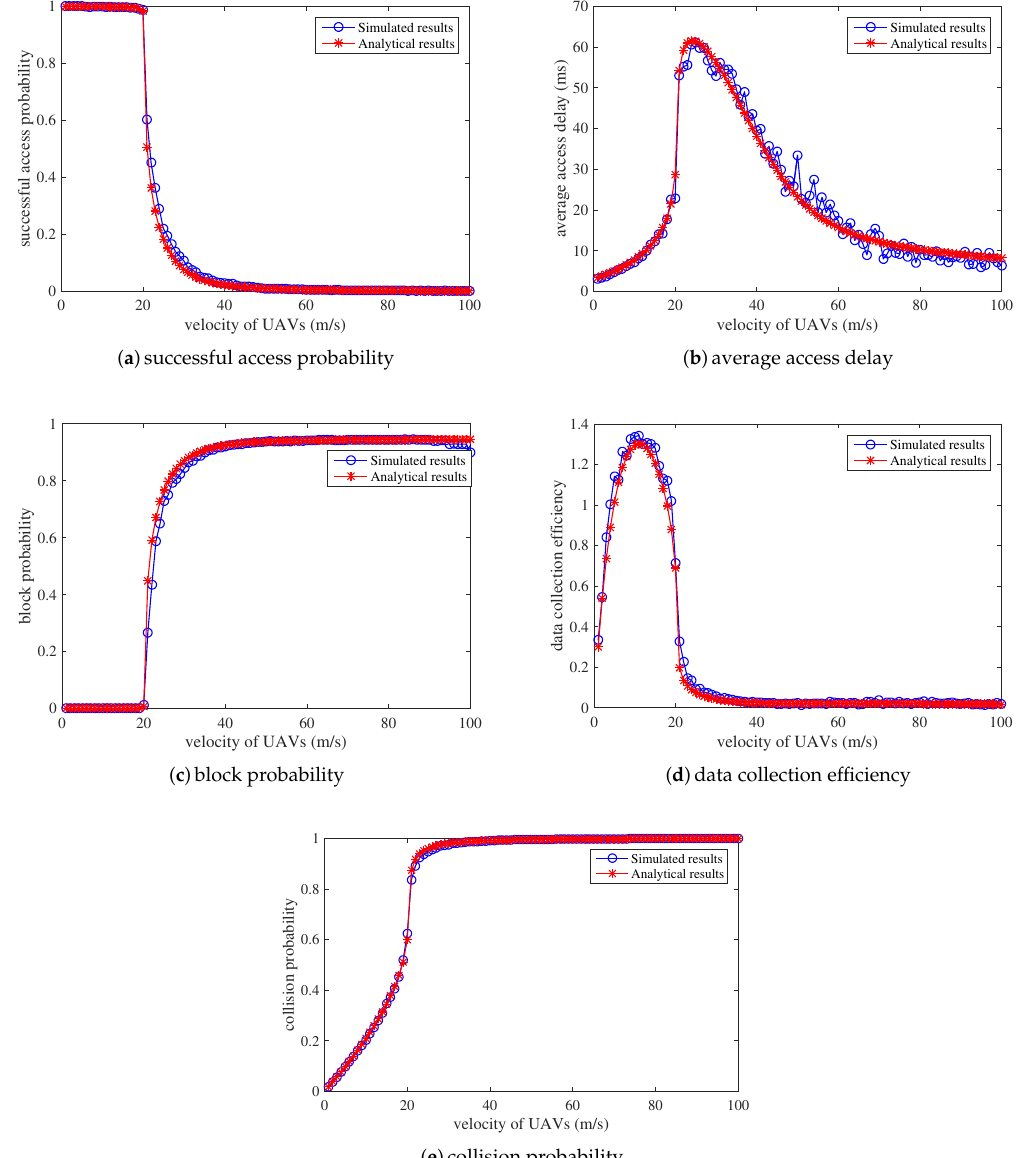
Figure 6. Verification of proposed analytical models when λ =